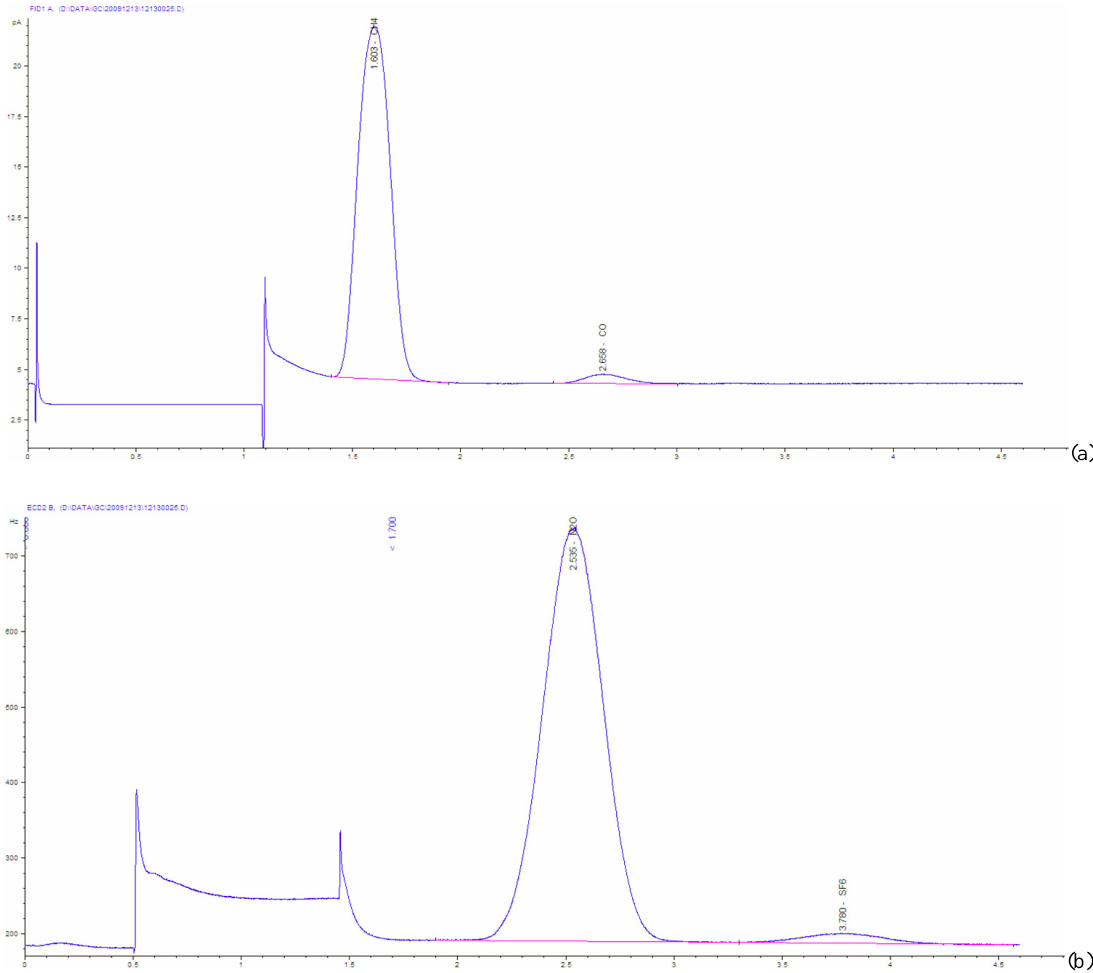
Fig. 7. Example chromatograms showing (a) the response of the FID in pA for CH 4 resp. CO and (b) the response of the ECD in Hz for N 2 O resp. SF 6 . The bottom time axis runs from 0 to 5min (period C2). In the interval between 0 and 1.1min (FID) and 0.5 and 1.5min (ECD) the detector is switched directly to carrier gas by the shunt valve (V2 and V4 in Fig. 6) to prevent preceding peaks polluting the detector, thereby enabling maximum stability of the